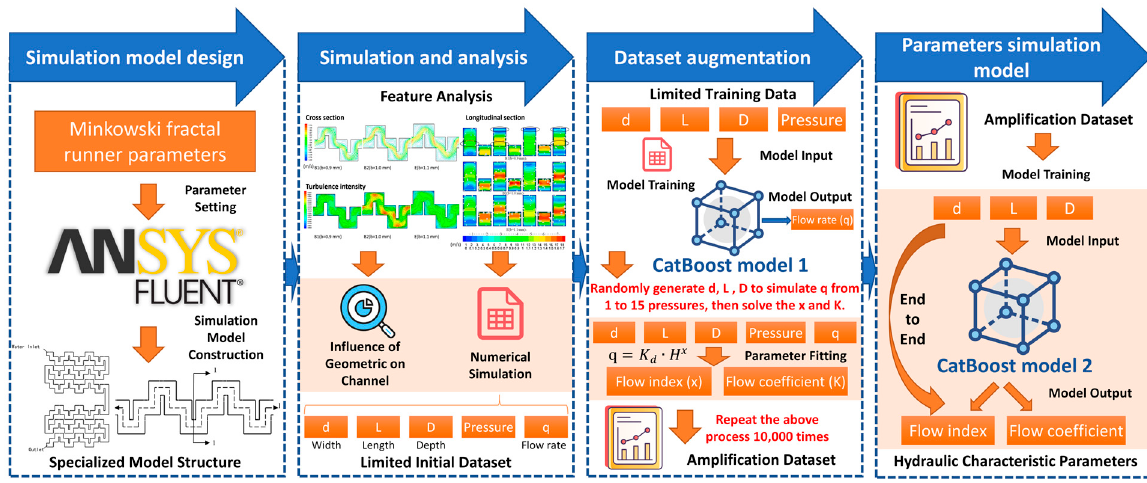
Figure 1. Overall technical solution.